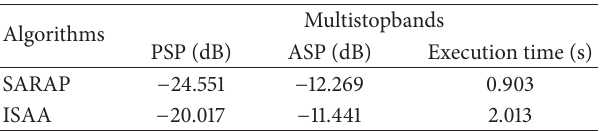
Table 5: Algorithms comparison for suppressing narrowband inter- ference and sidelobe